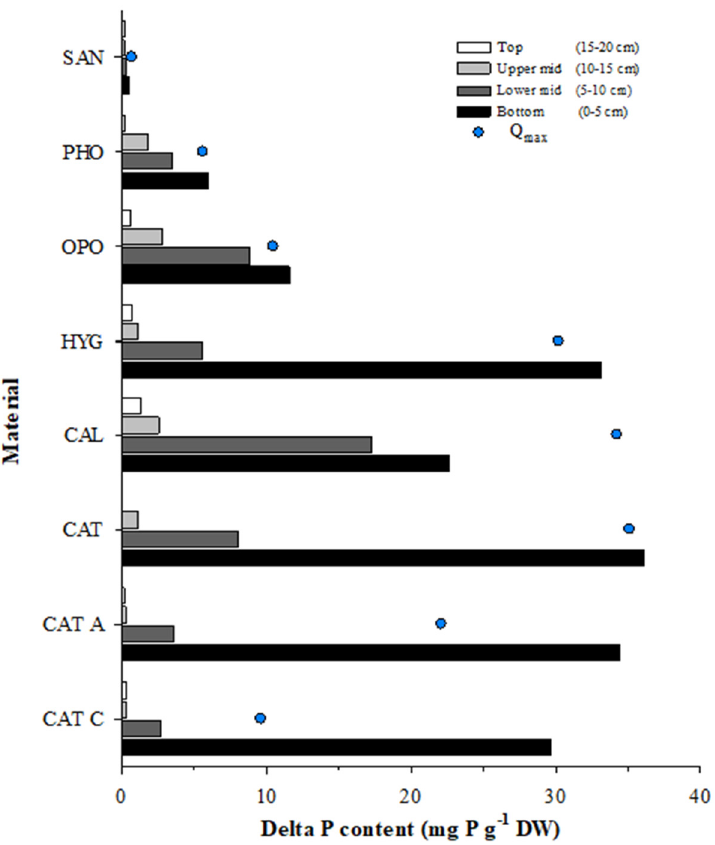
Figure 3. Delta P content in the four height fractions. The delta P content (mg P g − 1 DM) is the P content measured in the fractions after termination subtracted the initial measured P content (in the original material). A positive delta P indicates an accumulation of P while a negative delta P indicate a loss of P. The four fractions are: top (15–20 cm), upper-mid (10–15 cm), lower-mid (5–10 cm), and bottom (0–5 cm). Columns were up-flow fed. Bars show average ( n = 2) except for CAL ( n = 1). The maximum adsorption capacities ( Q max ) were determined by fitting the non-linear Langmuir model in Jensen [23].